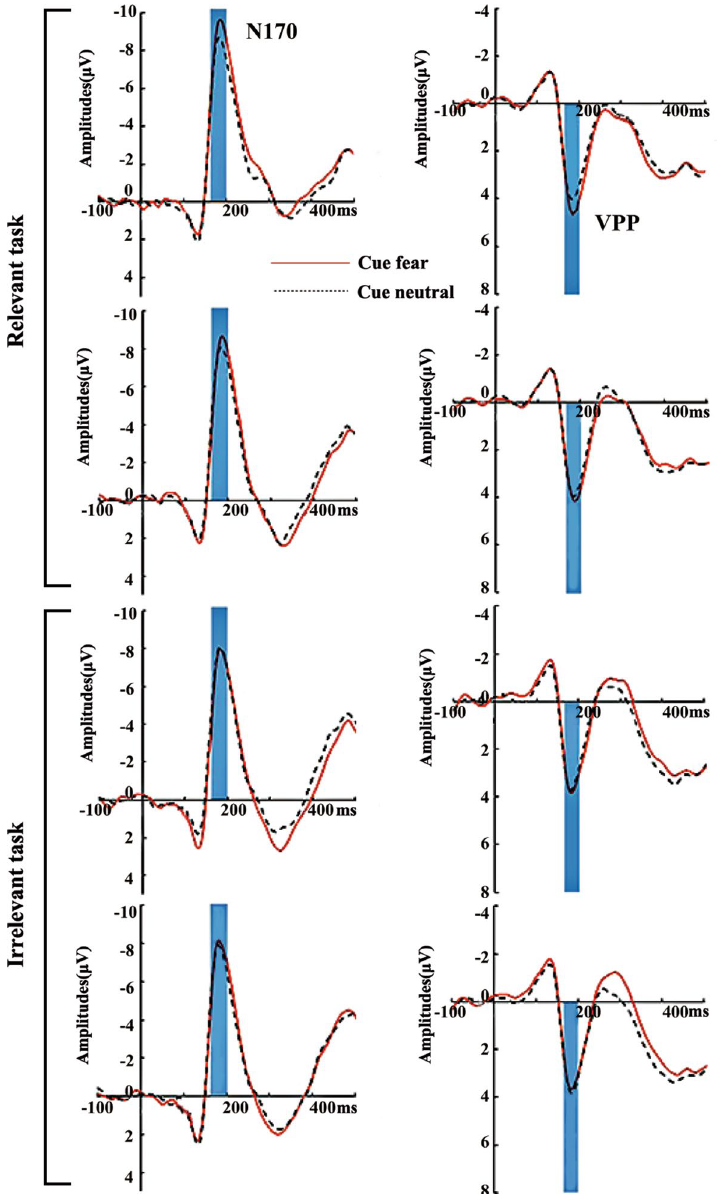
Figure 2. Grand-average waveforms for four top-down controls at ROI of electrodes. ( A ) The fearful faces in the cue position (red solid line) and the neutral faces in the cue position (black dotted line) on the valid cue- relevant task condition. ( B ) The fearful faces in the cue position (red solid line) and the neutral faces in the cue position (black dotted line) on the invalid cue-relevant task condition. ( C ) The fearful faces in the cue position (red solid line) and the neutral faces in the cue position (black dotted line) on the invalid cue-irrelevant task with the same gender-dependent condition. ( D ) The fearful faces in the cue position (red solid line) and the neutral faces in the cue position (black dotted line) on the invalid cue-irrelevant task with different gender- dependent